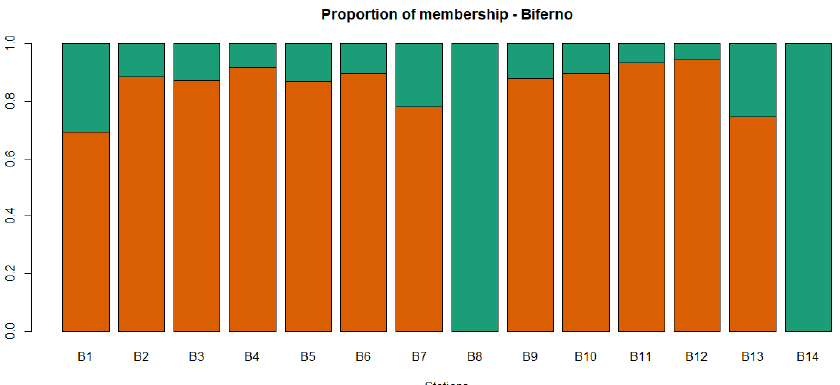
Figure 5. Proportion of membership of each sampling locations in each of the 2 clusters estimated in ADMIXTURE for the Biferno river. Orange and green colors represent group 1 and group 2, re- spectively.